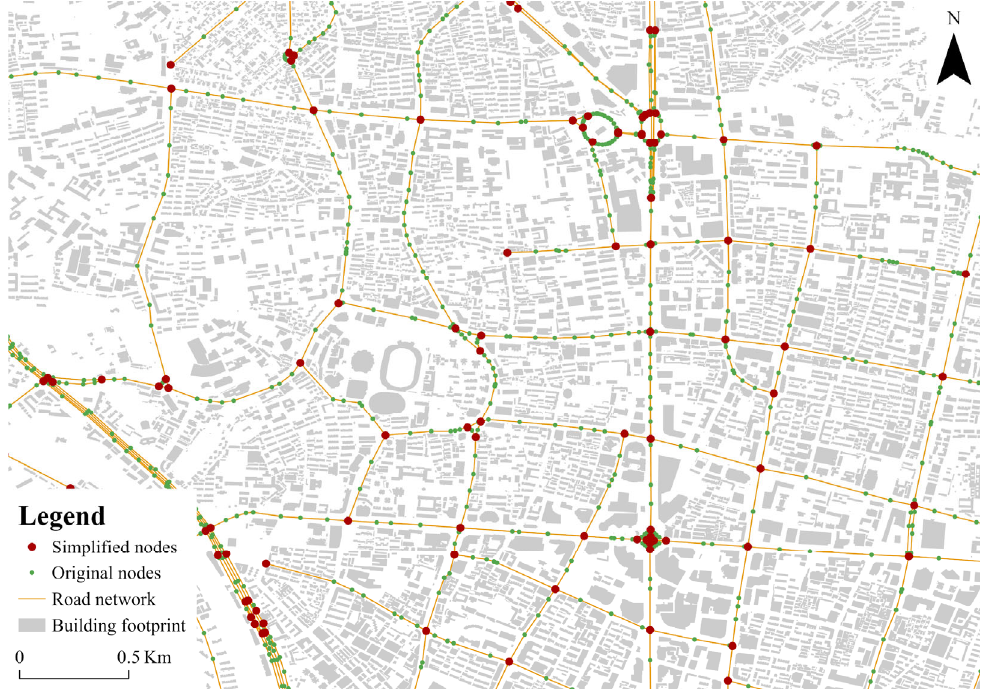
Figure 4. A c omparison of simplified nodes and original nodes in the central area of Nanjing. Figure 4. A comparison of simplified nodes and original nodes in the central area of